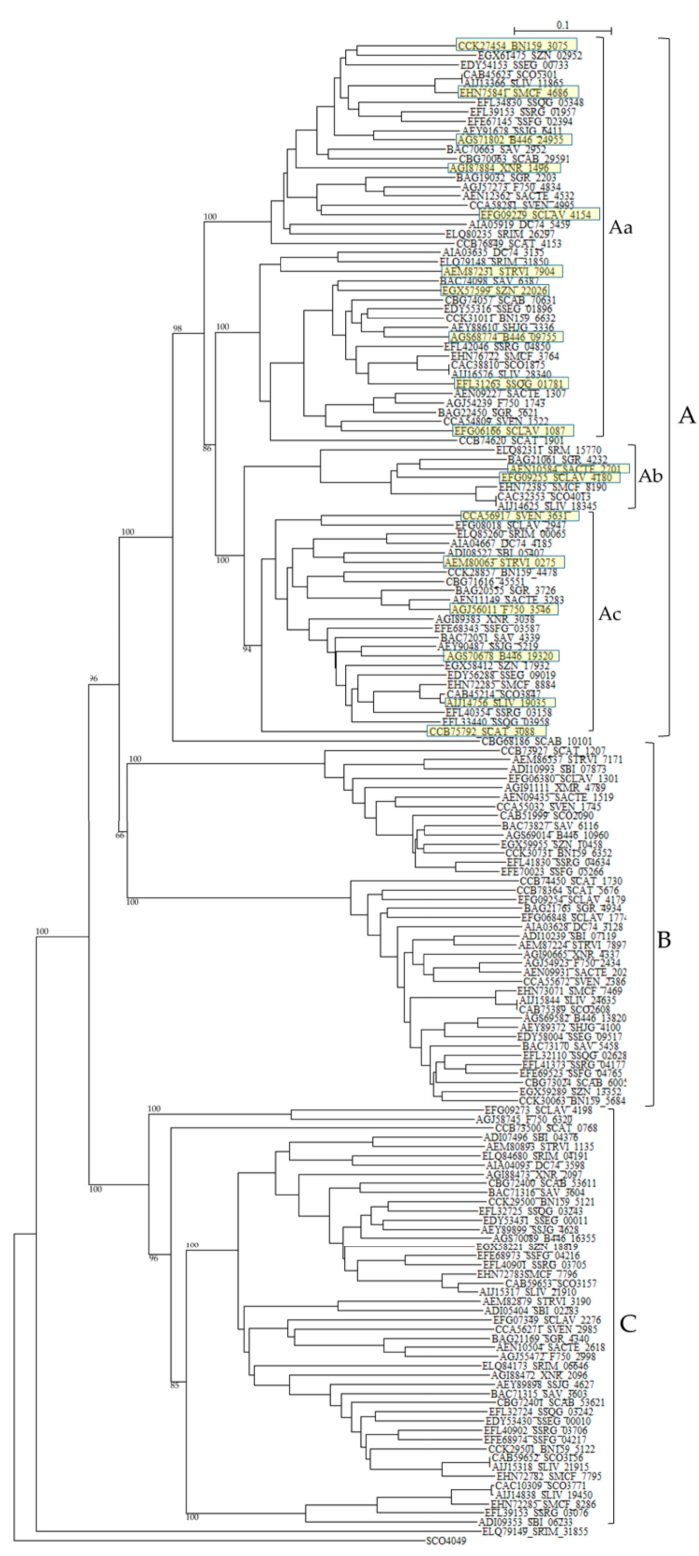
Figure 5. Phylogenetic tree of putative 161 class B PBPs on the basis of amino acid sequences. The tree was constructed by using ClustalX 2 [88] and S. coelicolor putative penicillin acylase (SCO4049, CAC32320) as outgroup. The sequences marked with yellow boxes were used for the calculation of molecular distances (Table S9). The bootstrap probabilities are shown at branching nodes. The phylogenetic tree were arbitrary divided to three groups, A, B, and